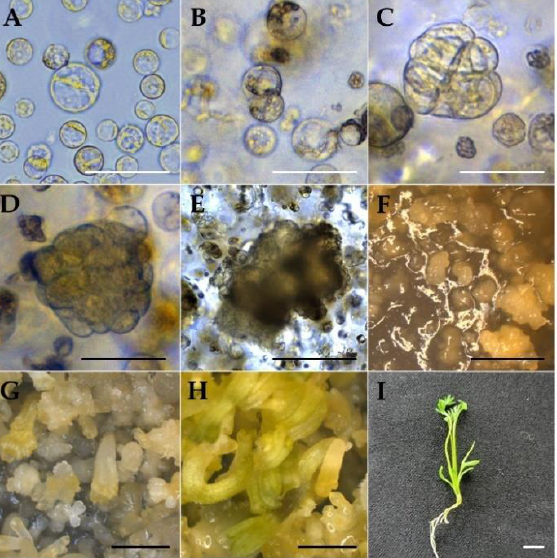
Figure 4. Different stages of EC-derived protoplast isolation and culture: ( A ) freshly isolated protoplast; ( B ) first cell division; ( C ) second cell division; ( D ) multi-cell division; ( E ) micro-callus formation; ( F ) EC and heart stage; ( G ) heart–torpedo stage ( H ); cotyledonary stage; ( I ) plant regeneration. ( A – C : bar = 50 µm, ( D , E ) bar = 100 µm, ( F – I ) 2 mm.